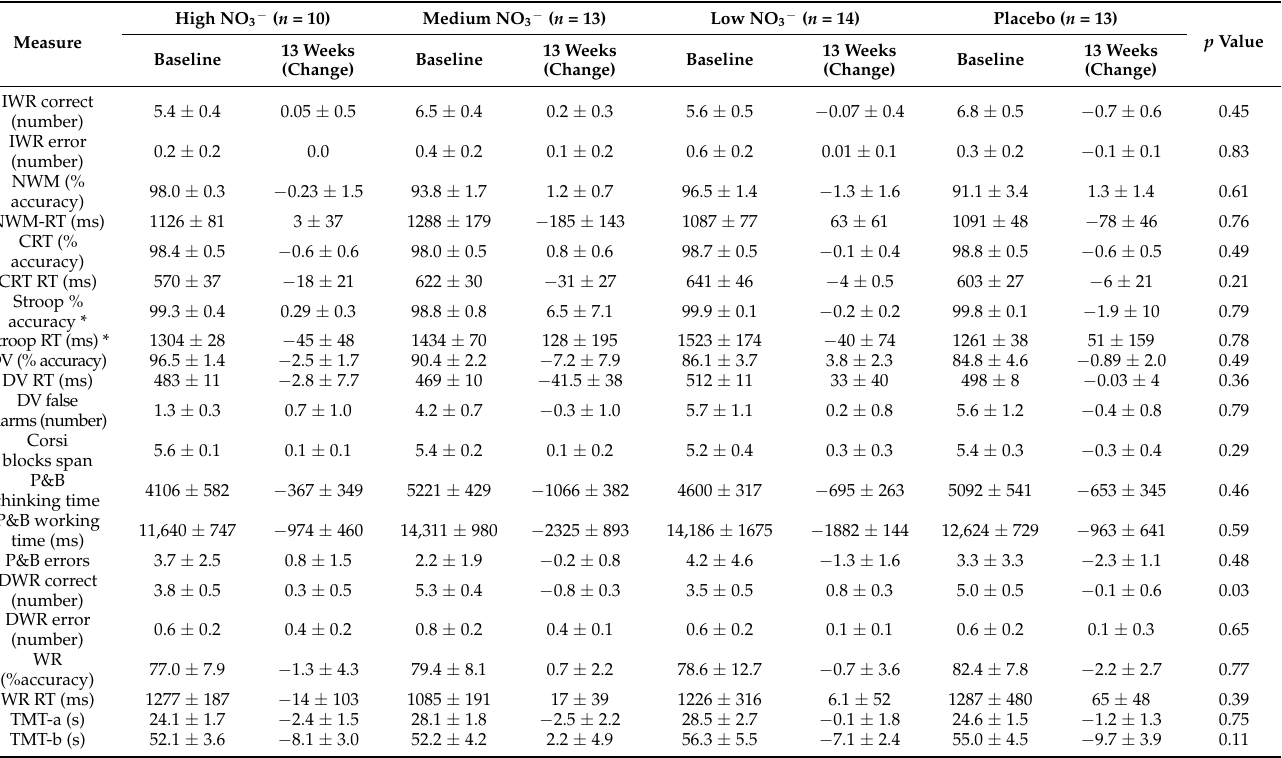
Table 2. Mean values for baseline and for change from baseline after 13 weeks of intervention on individual cognitive tasks for different doses of nitrate.